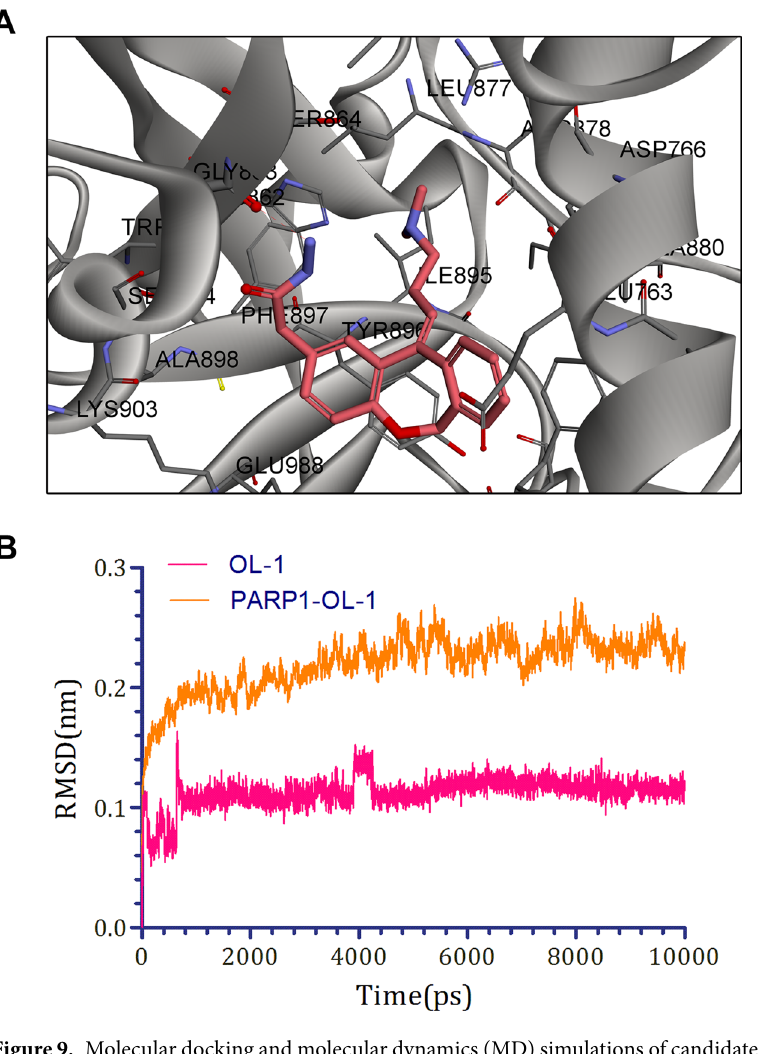
Figure 9. Molecular docking and molecular dynamics (MD) simulations of candidate PARP1 inhibitor OL-1. ( A ) Molecular docking of PARP1/OL-1 complex indicated that two hydrogen bonds were formed with GLY863. ( B ) Molecular dynamics (MD) simulations of OL-1 binding to PARP1. The binding conformation was stabilized after 10 ns simulation.